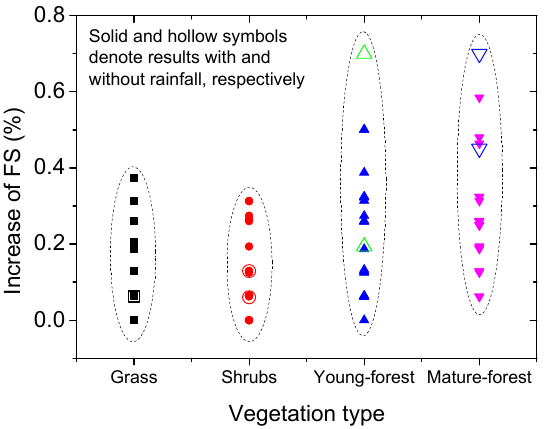
Figure 15. Comparison of the results of different vegetation on reinforcement of the slope.